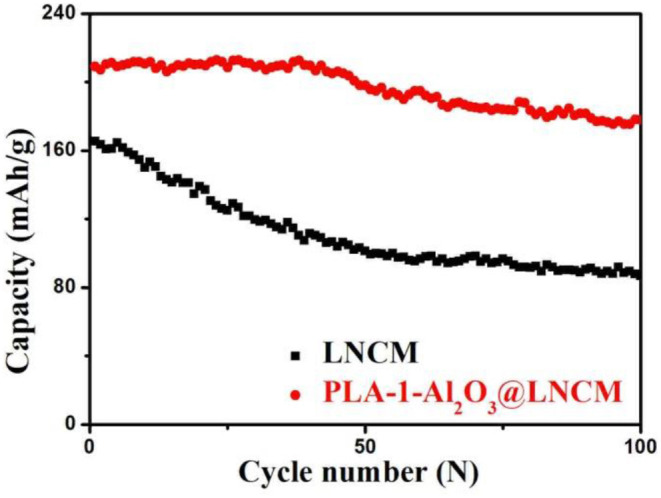
Cyclic performances at 0.2°C of LNCM and PLA-1-Al2O3@LNCM at 55°C.